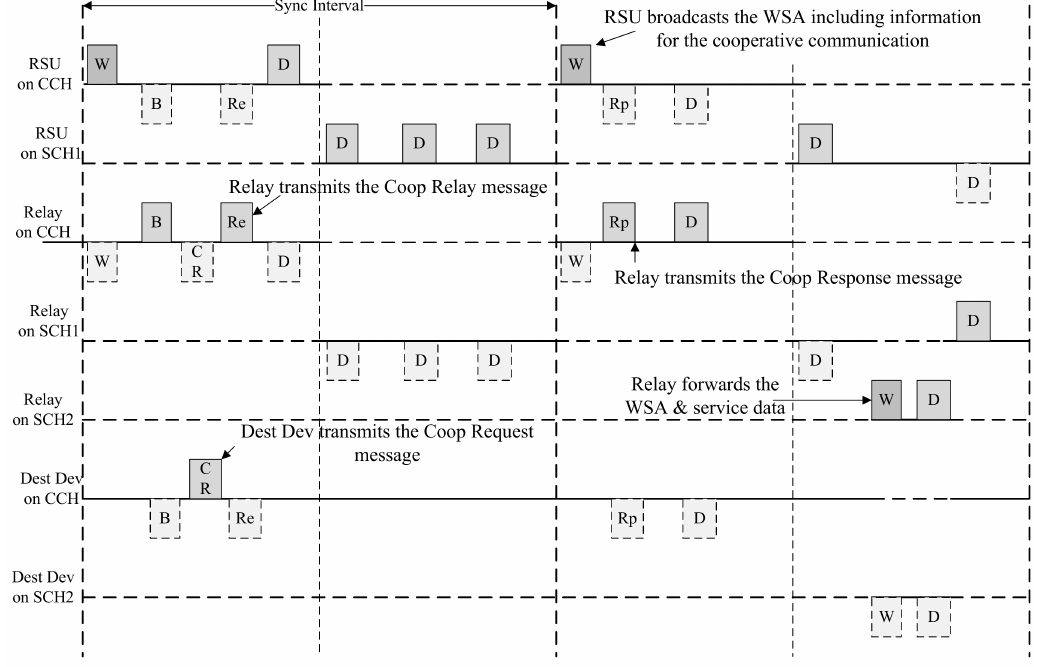
Figure 10. An example for the proposed cooperative communication